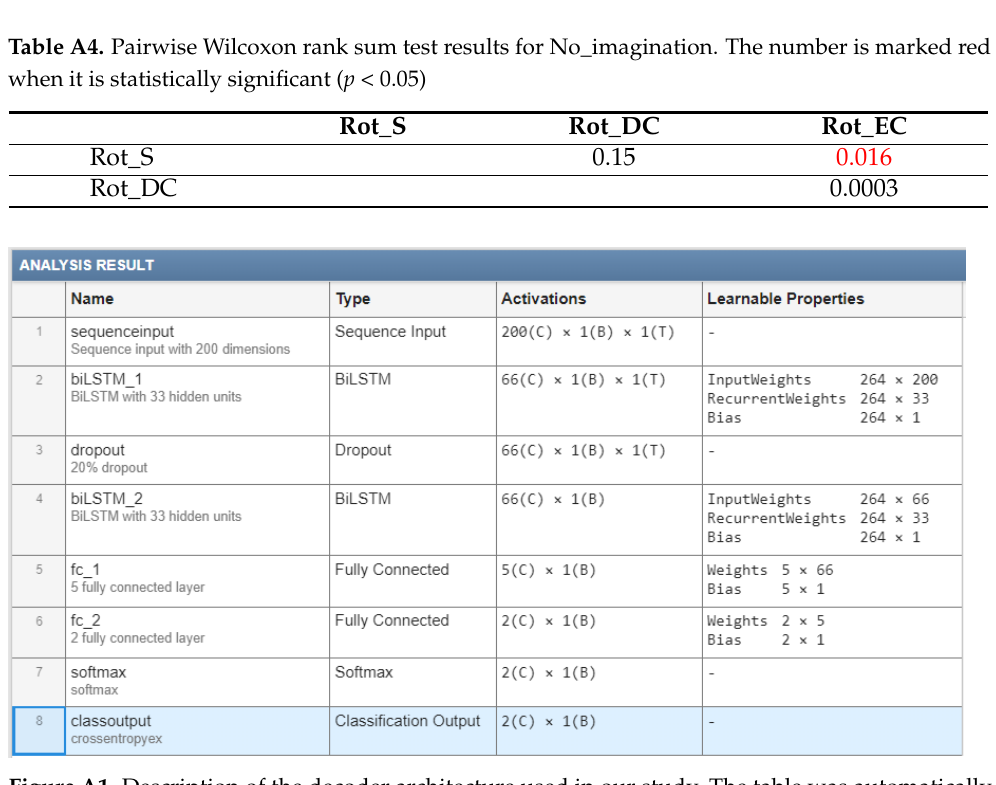
Figure A1. Description of the decoder architecture used in our study. The table was automatically generated by MATLAB’s analyzeNetwork